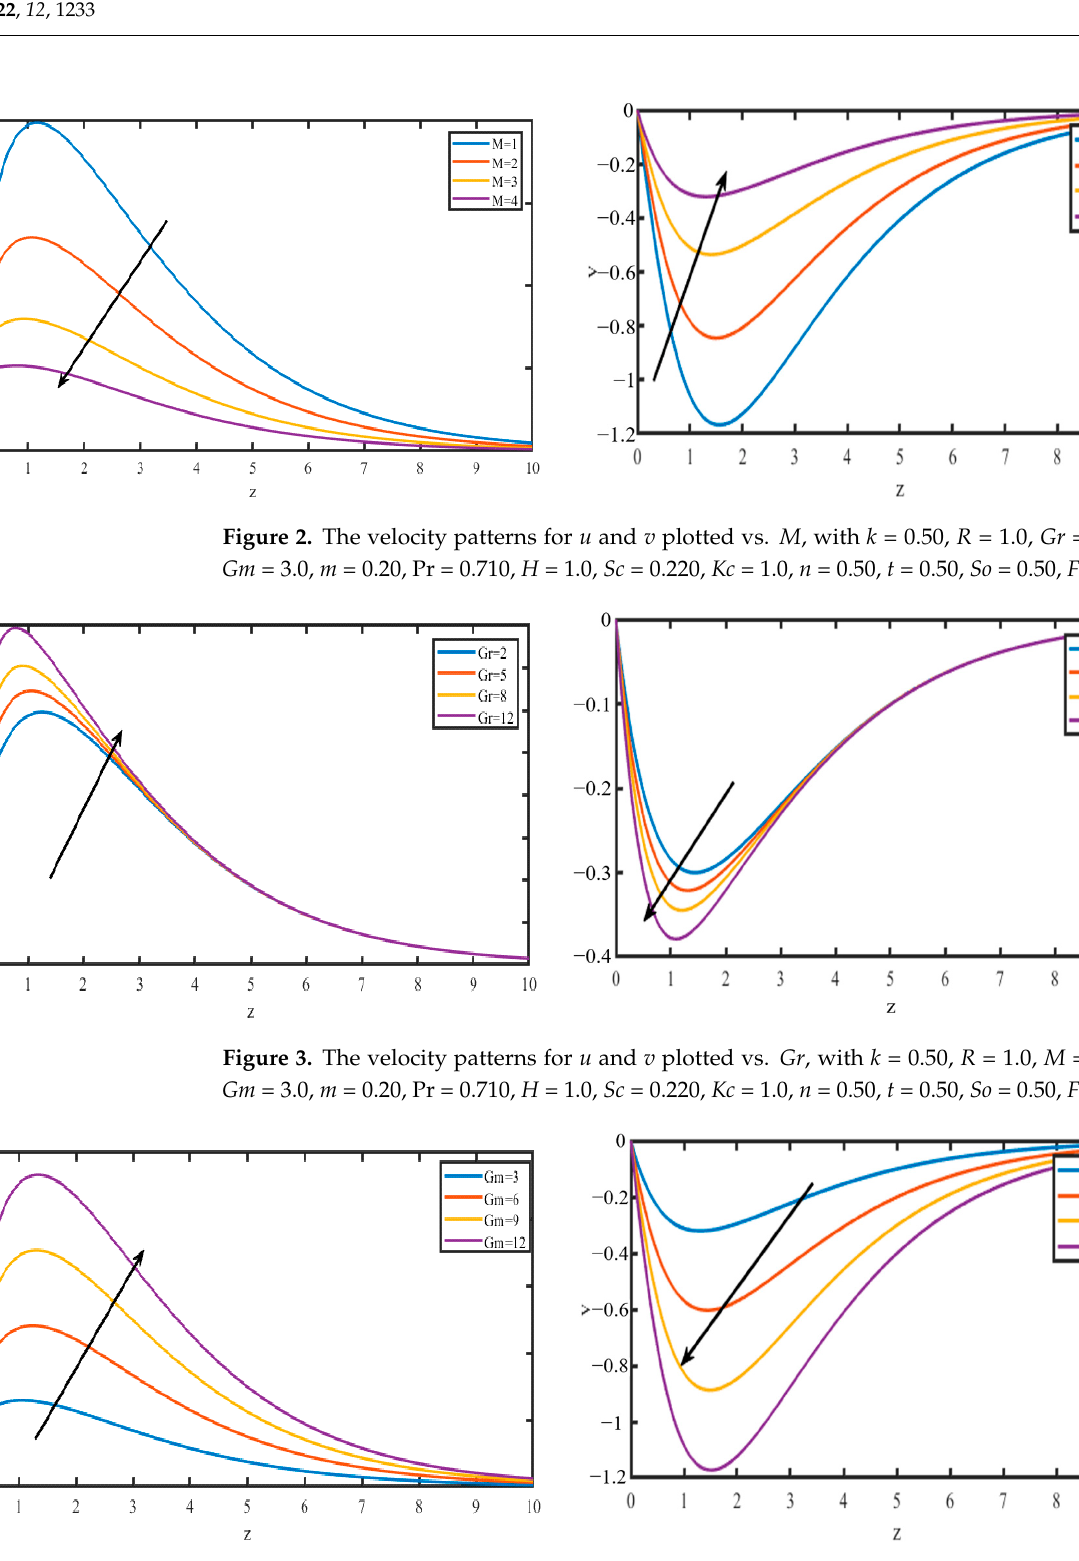
Figure 4. The velocity patterns for u and v plotted vs. Gm, with k = 0.50, R = 1.0, Gr = 5.0, S = 1.0, M = 2.0, m = 0.20, Pr = 0.710, H = 1.0, Sc = 0.220, Kc = 1.0, n = 0.50, t = 0.50, So = 0.50, F = 1.0.